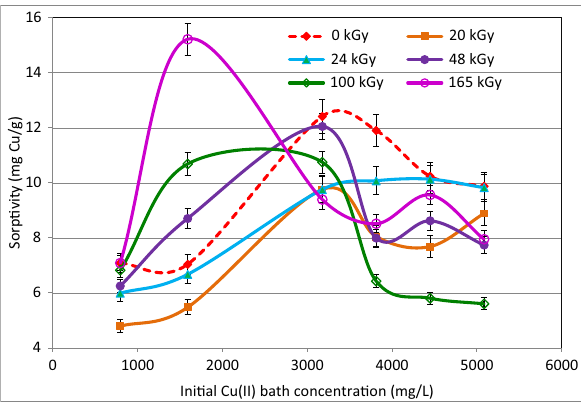
Figure 1: Sorptivity of Cu ( II ) on wool native and electron irradiated with various absorbed